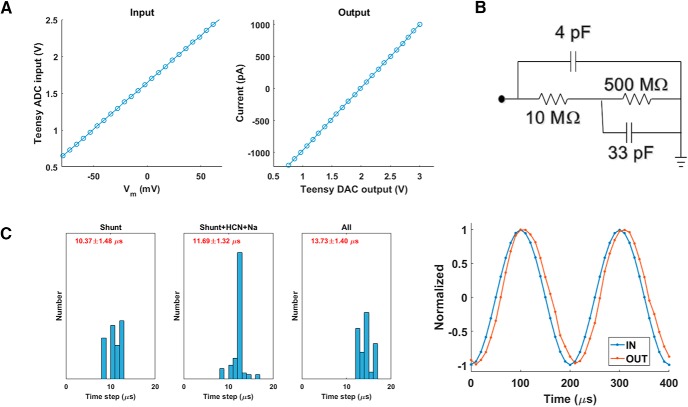
Calibrating and testing the system. A, Although the electronic components were not ideal, the input-output characteristics of the system were highly linear. Left, the voltages measured by the microcontroller’s analog input in response to a range of membrane potentials. Right, the currents injected into a model cell in response to a range of voltages sent out by the microcontroller’s analog output. B, To test the system, a model cell was attached to the intracellular amplifier’s headstage. Shown is the model’s equivalent circuit. C, The system’s speed approaches 100 kHz and depends only weakly on the number of conductances being simulated. We recorded the durations of 51,200 time steps (at microsecond resolution) for each of three dynamic clamp configurations: shunt conductance only; shunt, HCN, and sodium conductances together; and shunt, HCN, sodium, Ornstein–Uhlenbeck, and EPSC conductances all together. Shown in the three figures at left are the resulting histograms; the number at the top of each is mean ± SD. The temporal jitter in all cases was 1–2 μs. To check the temporal latency, sinusoidal voltages (5 kHz) were fed to the system’s input (replacing VIN of Fig. 2B) and the resulting outgoing current commands (VAMP of Fig. 2E) were measured for a shunt conductance (2 nS). Both the input signal and the output signal were sampled at 100 kHz. The latency between input and output was roughly 10 μs.